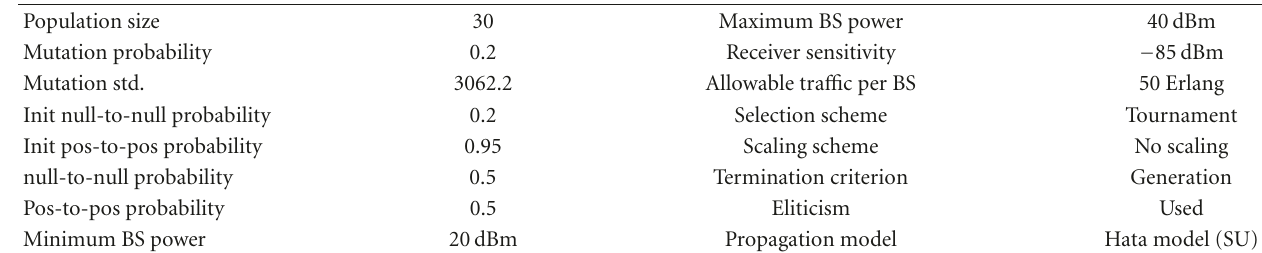
Table 3: Simulation parameters.